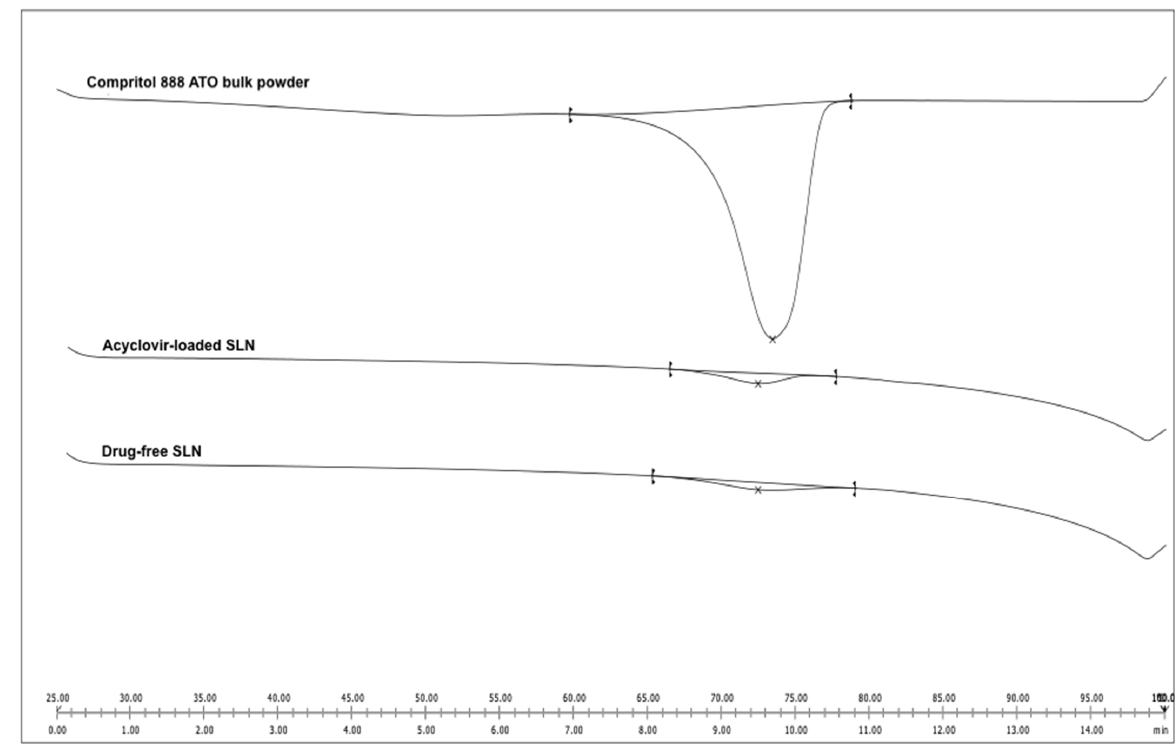
Figure 3. Differential scanning calorimetry thermograms of Compritol 888 ATO bulk powder, acyclovir-loaded SLN and drug-free SLN (blank). Table 4. Size, PdI and zeta potential measurement of SLN formulations stored at 4, 25 and 40 ◦ C.